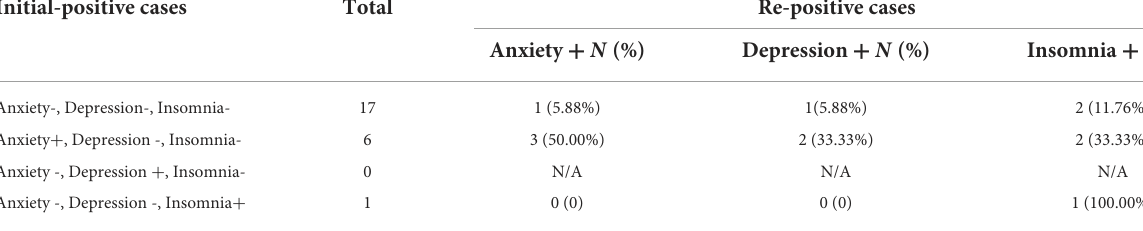
TABLE 4 The mutual changes of psychological symptoms after